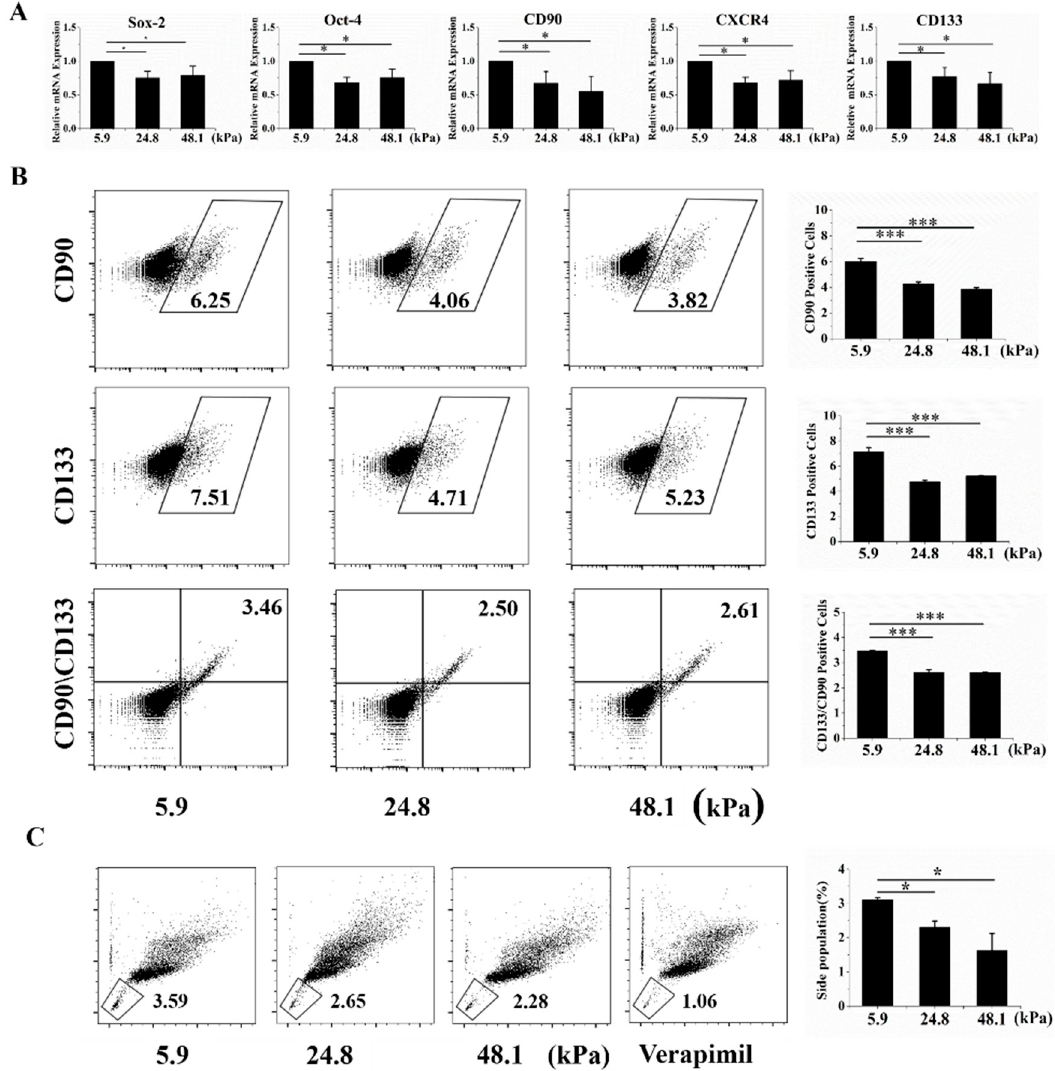
Figure 2. The soft matrix enhanced the expression of molecular markers of stemness. ( A ) The soft matrix increased the mRNA expression levels of the cancer stem cell markers Oct-4, Sox-2, CXCR4, CD133, and CD90, as indicated by qRT-PCR. All the results are normalized to 5.9 kPa. ( B ) Flow cytometry showed that the soft matrix increased the proportion of CD90+, CD133+, and CD90+CD133+ cells. ( C ) The soft matrix increased the number of side population (SP) cells, and the cells were stained with a negative control. The values are presented as the means ± SD of three independent experiments. n = 3; * p < 0.05; *** p < 0.001.